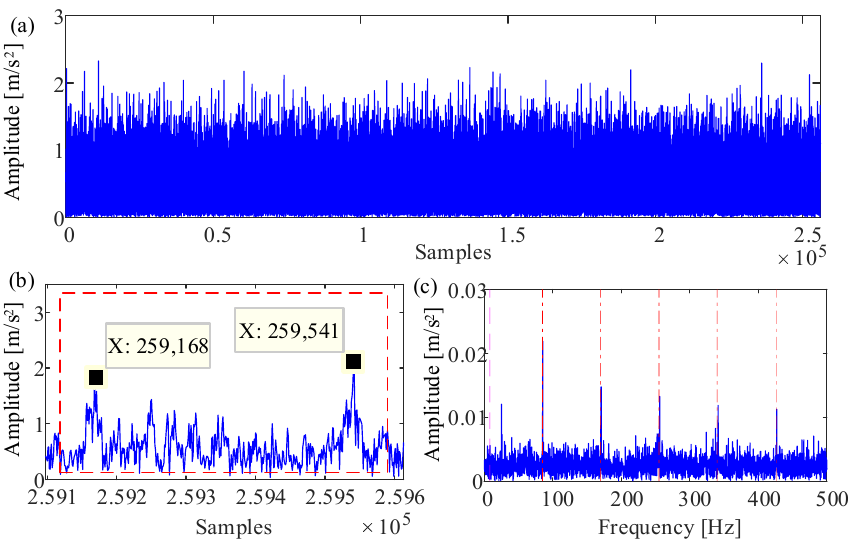
Figure 11. The results of experimental analysis at 500 rpm: ( a ) envelope signal filtered by AR and MED; ( b ) the local signal of ( a ); ( c ) the envelope spectrum of ( a ).